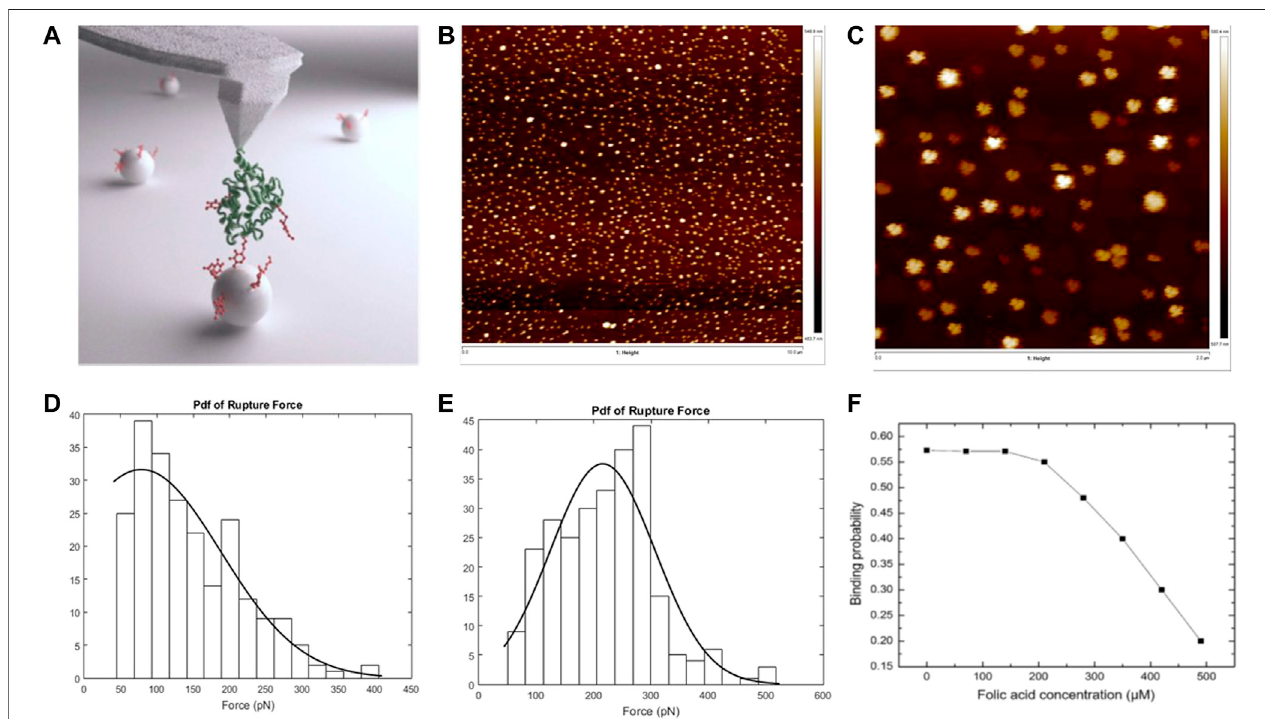
FIGURE4| Atomicforcemicroscopyinunderstandingthebindingdynamicsofthefolatereceptoralpha(FR α )withself-assemblednanoparticles(micelleplexes)vs. free folic acid. (A) Graphical abstract representing interaction between AFM cantilever tip functionalized with FR α and substrate functionalized with folic acid conjugated nanoparticles. (B) TappingmodeAFMimagesofmicelleplexes:topographicalimageofmicelleplexesonaglasscoverslipof25 × 25 mm;scansize,10 μ m. (C) Zoomed in version of the topographical image shown in (B); scan size, 2 μ m. (D) Rupture force histogram plotted for substrate functionalized with free folic acid and tip functionalized with folate receptor. (E) Rupture force histogram for substrate functionalized with folate-decorated nanoparticles and tip functionalized with folate receptor. (F) Binding probability versus concentration of folic acid after injecting folic acid in the fl ow cell with the substrate, functionalized with folate-decorated nanoparticles and cantilever tip functionalized with folate receptor (Jones et al., 2017).